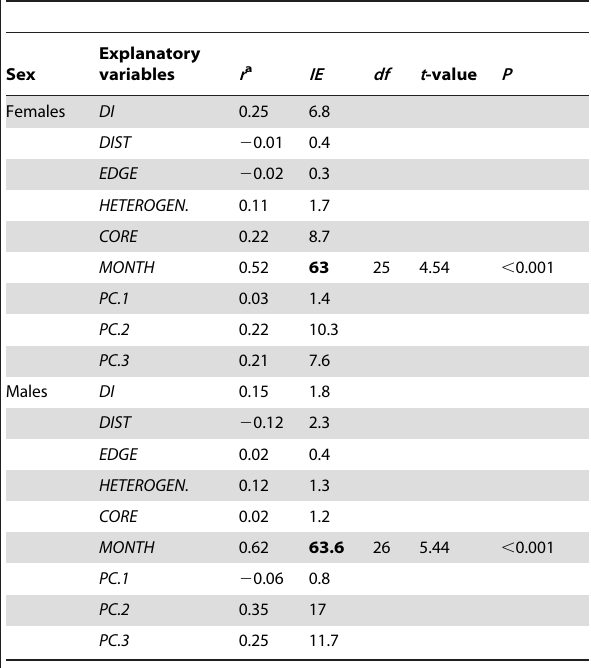
Table 10. Relationships between neutrophils (cells ? L 2 1 ) and environmental variables for agile antechinus.